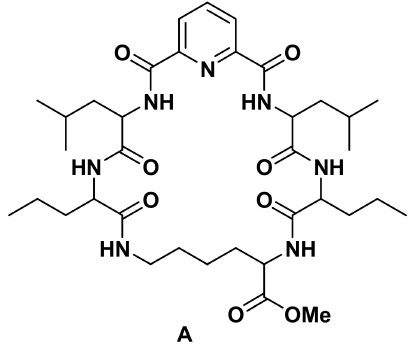
Figure 1. Structure of the anticancer